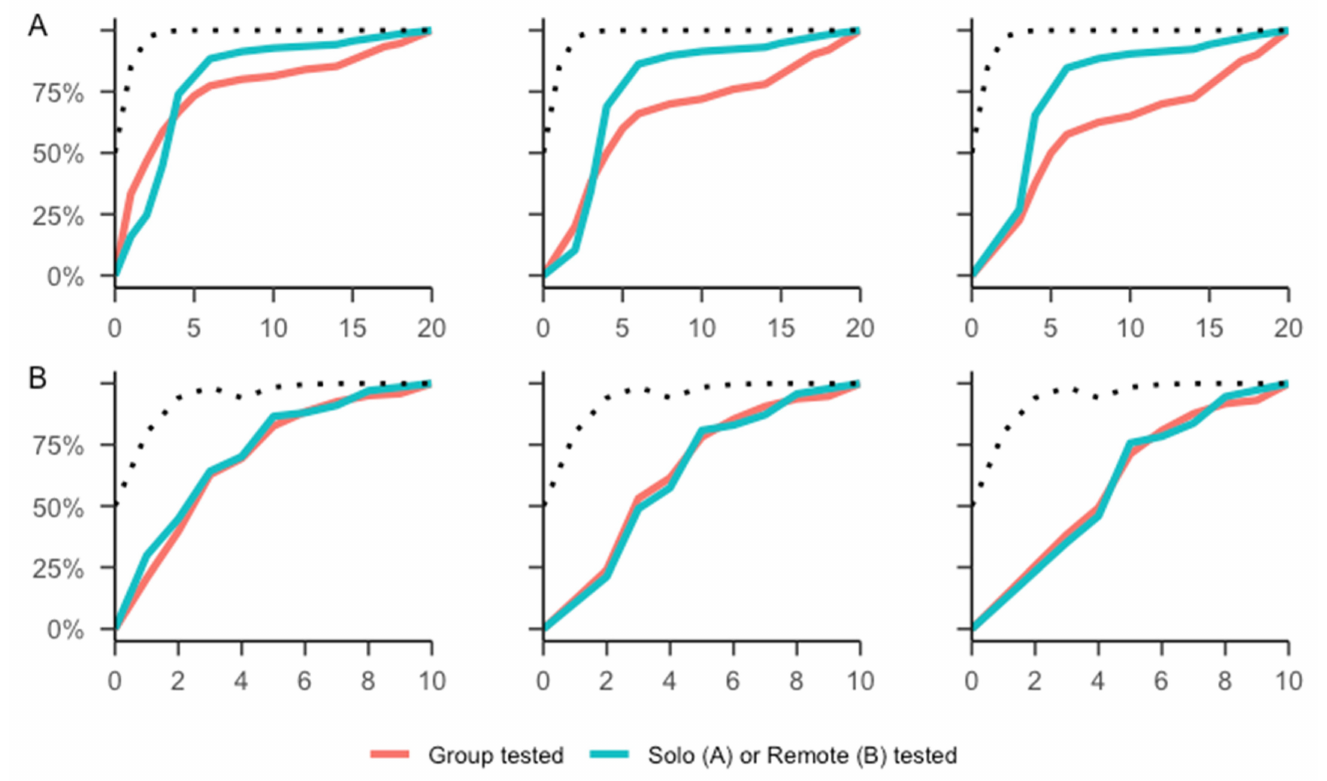
Figure 2. Cumulative proportion of participants having made a decision across the sequence of evidence (in red: group testing (samples 2 and 3); in blue solo/remote testing (samples 1 and 4)). ( A ) Abstract Draws to Decision variant. ( B ) Cover story variant. Left: all participants. Middle: with DtD = 1 participants excluded. Right: with DtD = 1 or 2 participants excluded. Ideal Bayesian Observer thresholds as black dotted